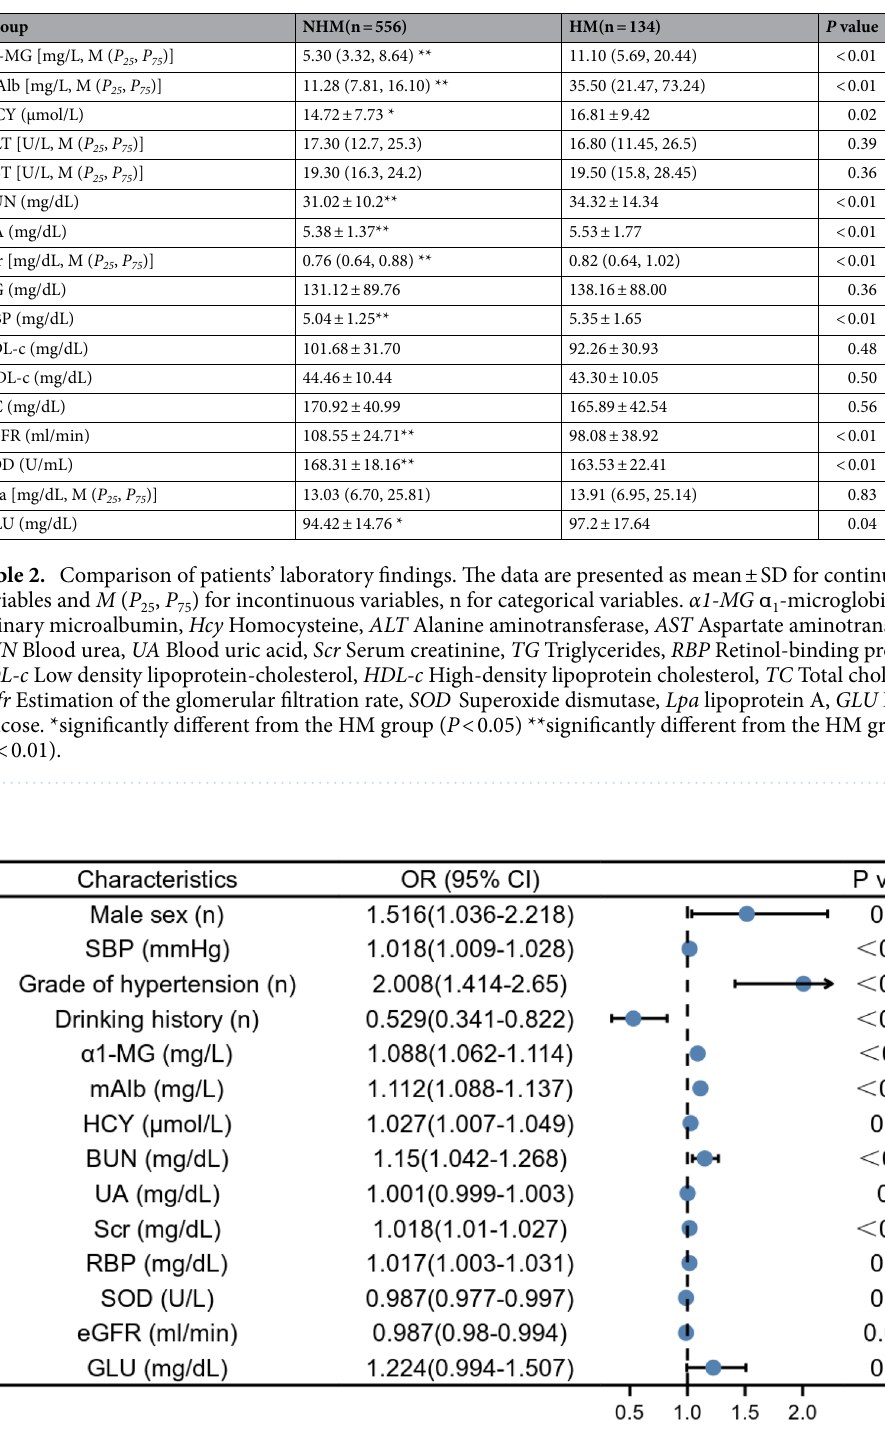
Figure 1. Univariate logistic analysis. SBP Systolic blood pressure, α1-MG ɑ 1 -microglobin, mAlb Urinary microalbumin, HCY Homocysteine, BUN Blood urea, UA Blood uric acid, Scr Serum creatinine, RBP Retinol- binding protein, SOD Superoxide dismutase, Egfr Estimation of the glomerular filtration rate, GLU Blood